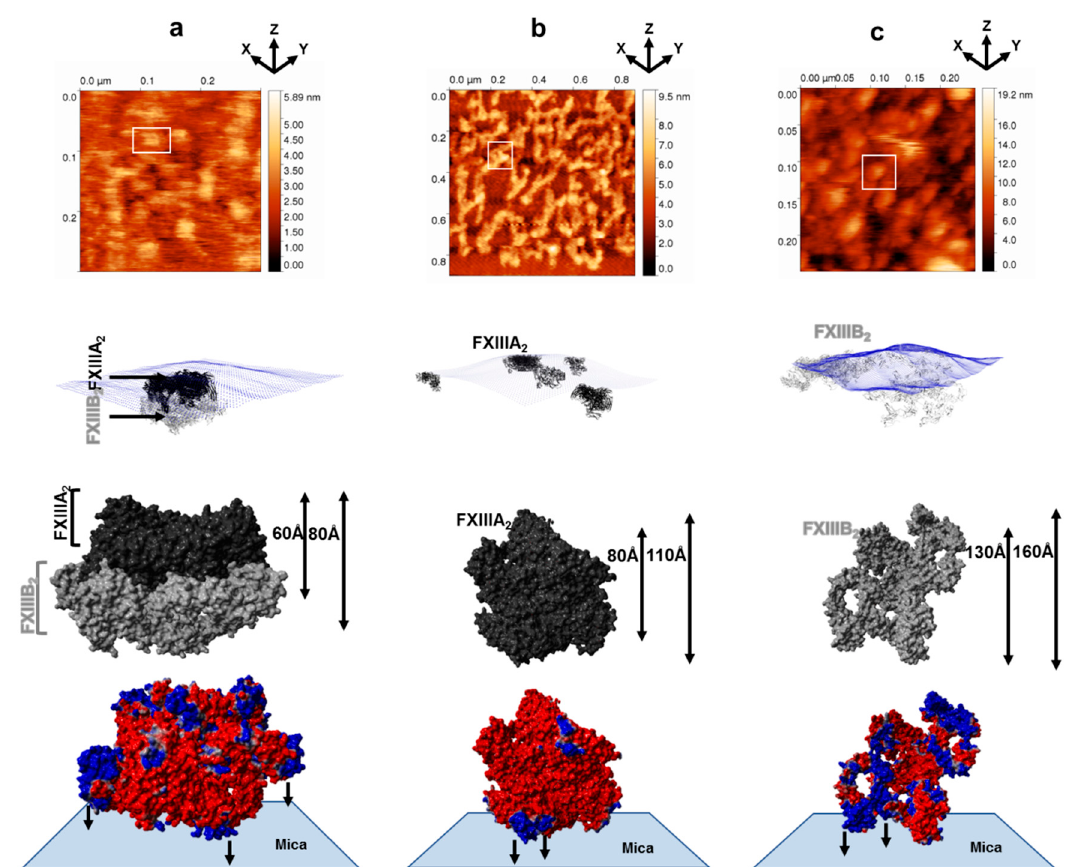
Figure 1. Conformational state of factor XIII (FXIII) complex, FXIII-A, and FXIII-B subunits by atomic force microscopy (AFM). Figure 1 is split row wise into panels a, b, and c running top to bottom. Figure 1a goes top to bottom in the following order for the AFM- and AFM-based docking of the best FXIII-A 2 B 2 complex model, i.e., the topmost image is the raw AFM image with the docking pose of one of the crops below it. In the docking pose, the topography is depicted as blue dots while the different docked complexes (of model one only) are depicted in black (FXIII-A 2 ) and gray (FXIII-B 2 ) ribbon format. Below the docking pose is a molecular surface-based representation of FXIII-A 2 B 2 complex as it would be viewed in one of the many poses it would adopt while adhering to the mica in the AFM instrument. The minimum and maximum heights that this pose is likely to have, are indicated to the right. The FXIII-A and FXIII-B subunits are depicted in black and gray color, respectively. The lowermost image is PME electrostatic surface structural representation of the same pose depicted in alignment with the hypothetical mica surface to which it adheres. Figure 1b,c panels follow the same trend as Figure 1a, only they represent the FXIII-A dimeric crystal structure and the dimeric unbound FXIII-B model, respectively.